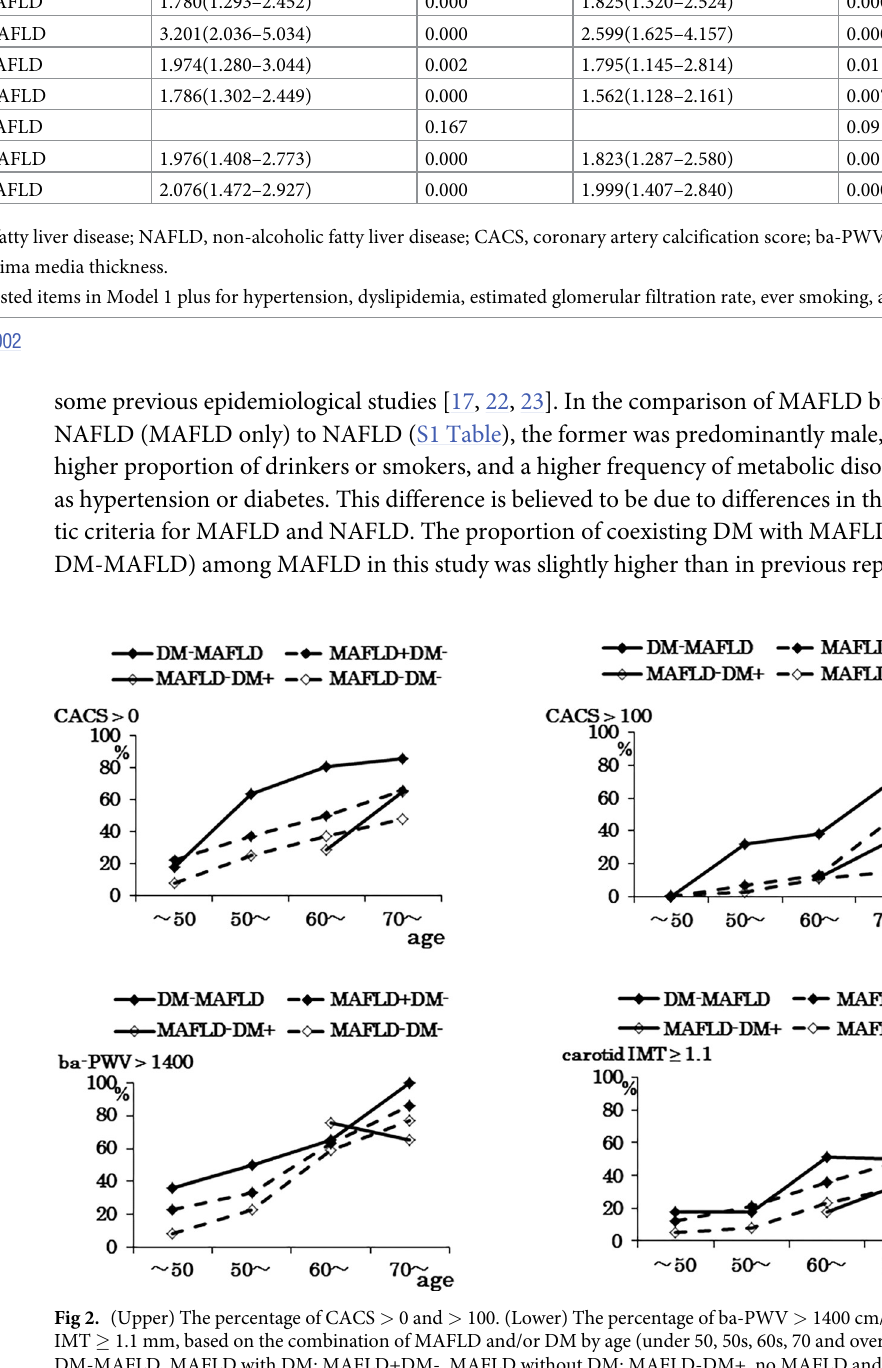
Fig 2. (Upper) The percentage of CACS > 0 and > 100. (Lower) The percentage of ba-PWV > 1400 cm/s and carotid IMT � 1.1 mm, based on the combination of MAFLD and/or DM by age (under 50, 50s, 60s, 70 and over). DM-MAFLD, MAFLD with DM; MAFLD+DM-, MAFLD without DM; MAFLD-DM+, no MAFLD and DM; MAFLD-DM-, no MAFLD and no DM. MAFLD, metabolic dysfunction-associated fatty liver disease; DM, diabetes mellitus; CACS, coronary artery calcification score; ba-PWV, brachial ankle pulse wave velocity; IMT, Intima media